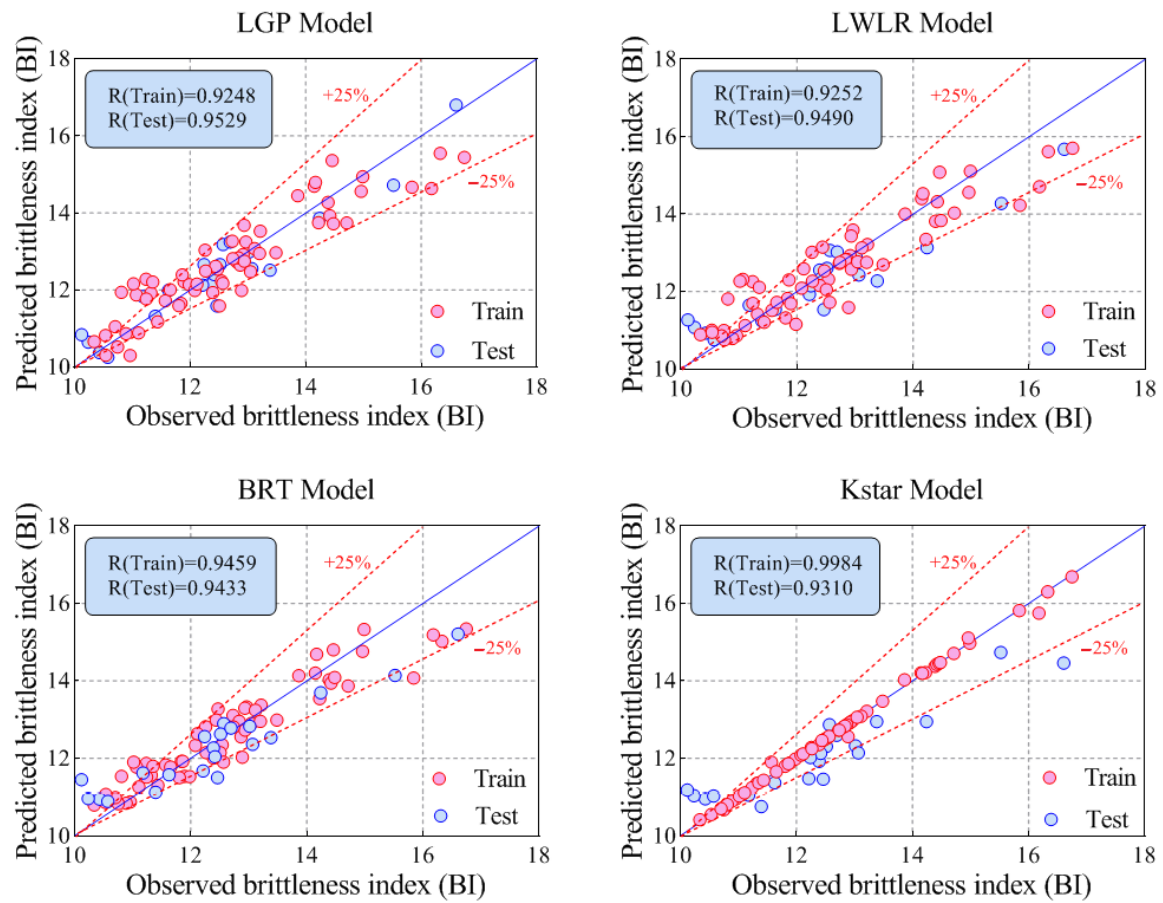
Figure 7. Comparison of four soft computing approaches and observed BI using scatter plot.